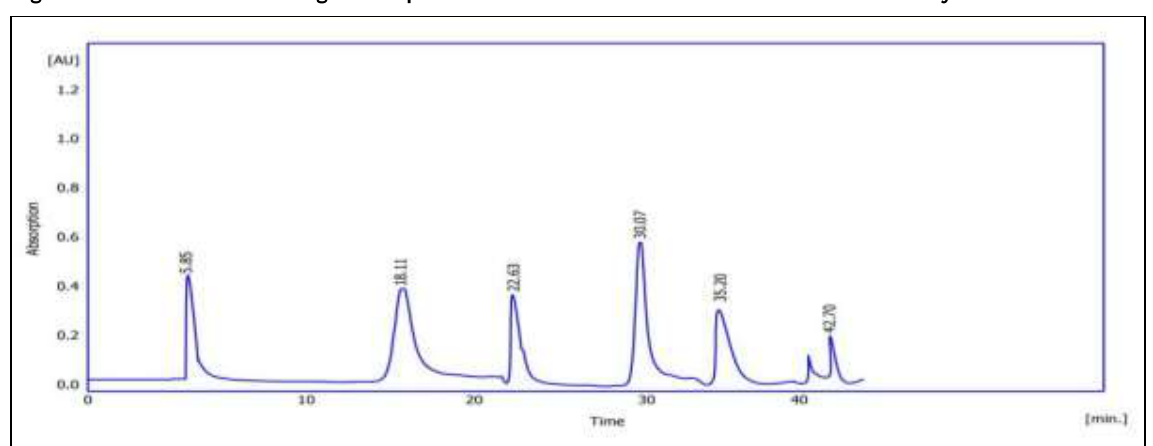
Figure 10. PHPLC chromatogram of petroleum ether fraction of leaves that extracted by hot method.